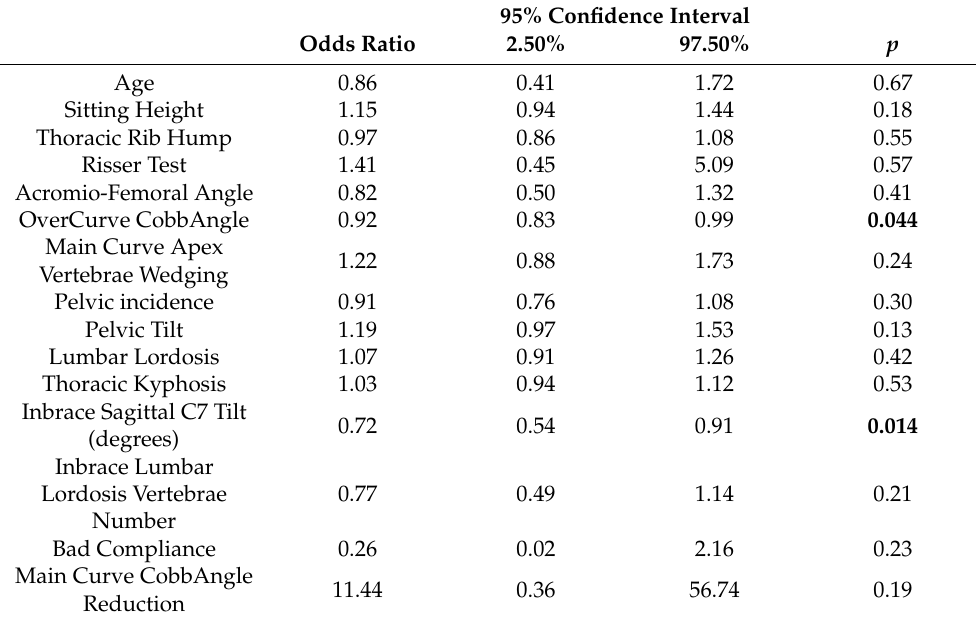
Table 6. Main thoracic multivariate analysis. Bold indicates p < 0.05